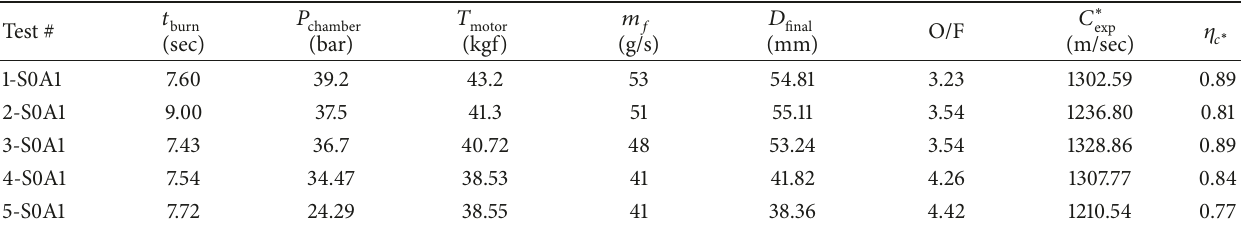
Table 2: Ballistic characteristics of axial flow tests.